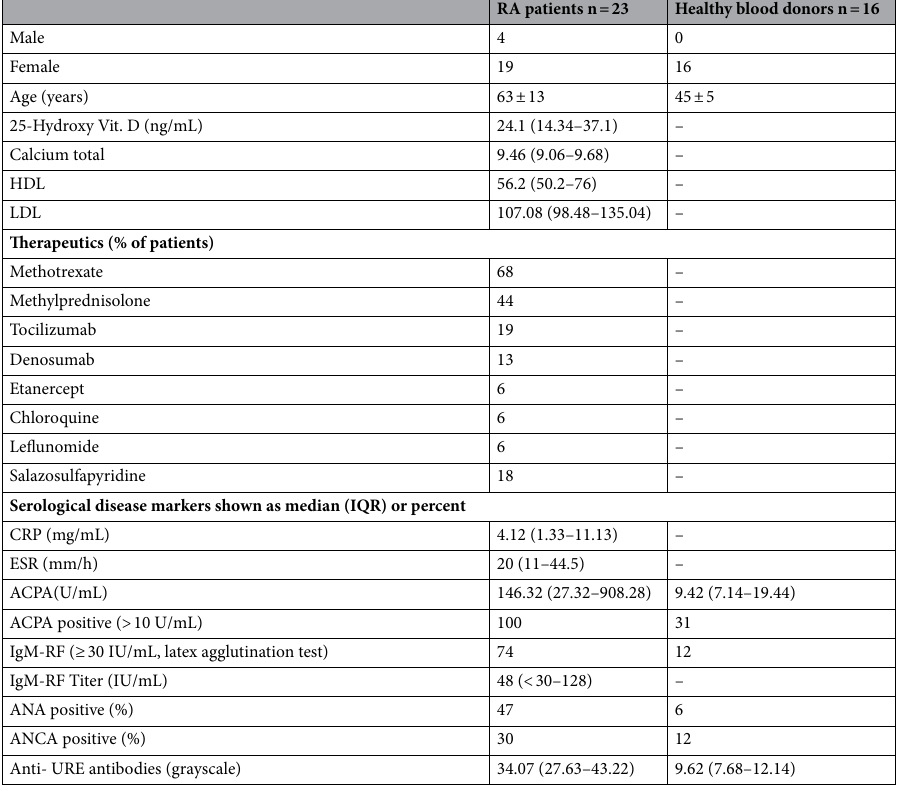
Table 1. Baseline information of RA patients and healthy blood